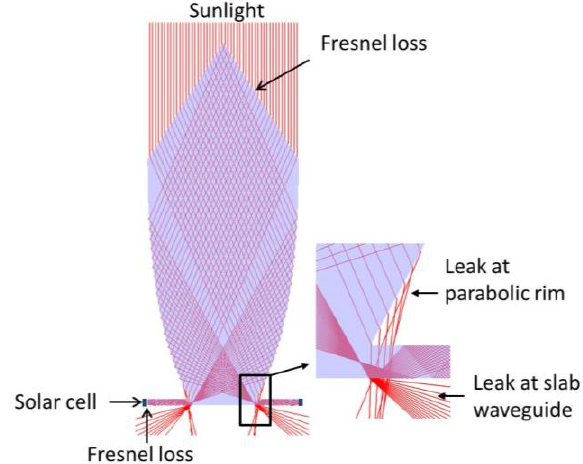
Figure 6. Loss mechanism of the system.